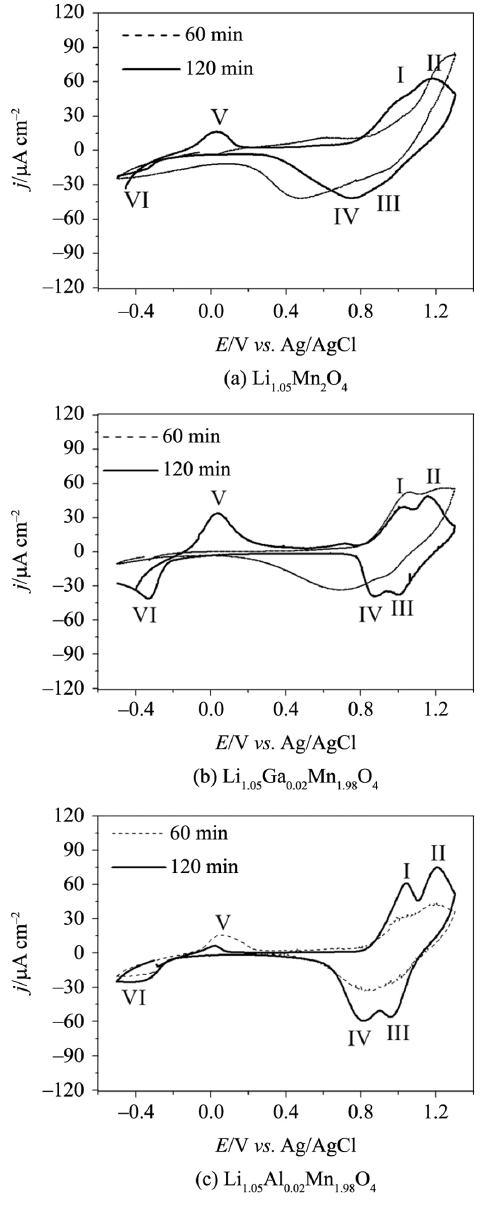
Figure 9. Cyclic voltammograms of the electrodes: (a) Li (b) Li Ga Mn O ; (c) Li Al Mn O , calcined at 750 °C 1.05 0.02 1.98 4 1.05 0.02 1.98 4 for 60 or 120 min; in EC/DMC LiClO 1 mol L –1 at 0.5 mV s –1 . 4